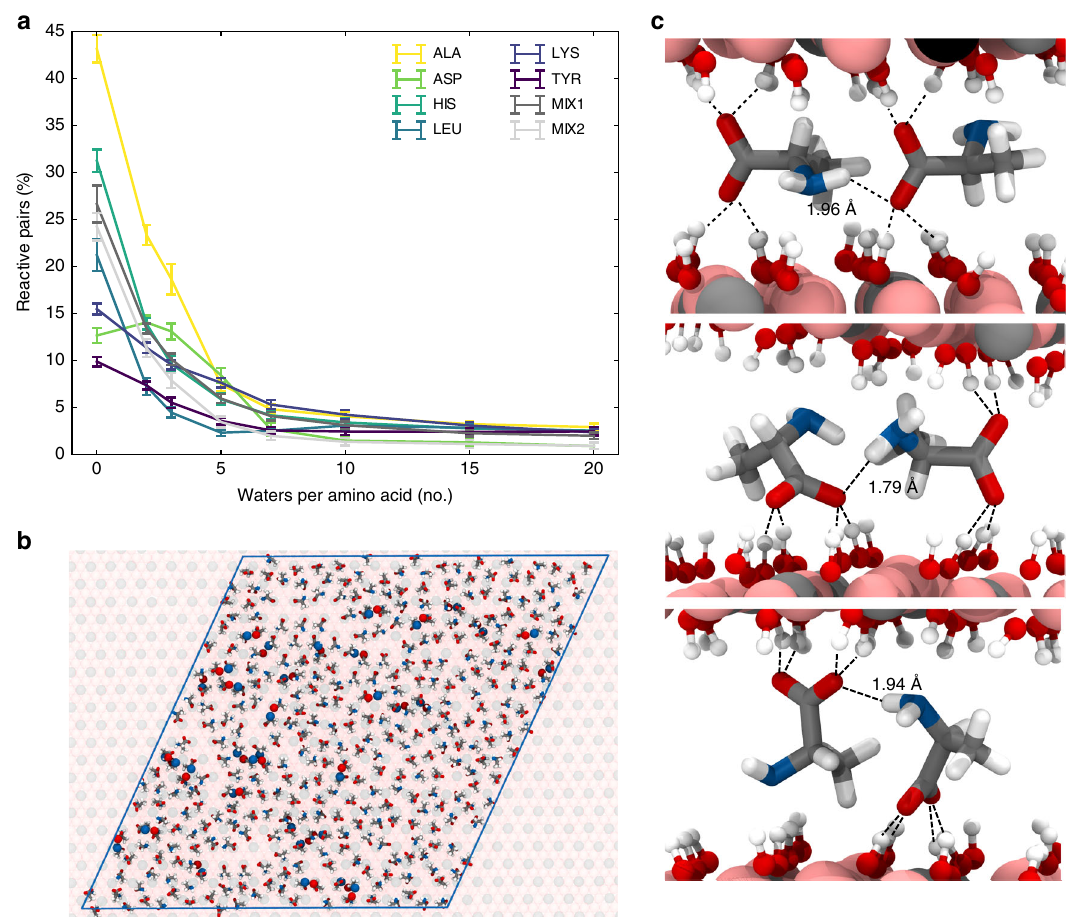
Fig. 3 Dehydration promotes formation of reactive pairs. a Percentage of amino acids' reactive pairs as a function of their hydration (number of water molecules per amino acids). Error bars represent standard deviation. For all amino acids, the percentage of reactive pairs in the system increases upon dehydration. b Top view of amino acids adsorbed and co-aligned onto the LDH surface, forming potential reactive pairs (shown spheres, where the backbone nitrogen is colored in blue, and most proximal backbone oxygen in red). c Reactive pairs show a range of different possible orientation, involving one or both adjacent LDH layers. Colors are as follows: Mg, pink spheres; Al, gray spheres; Cl, blue spheres; O, red; H, white; N, blue; and backbone is represented with yellow spline. For clarity water and H-atoms on the amino acids are not